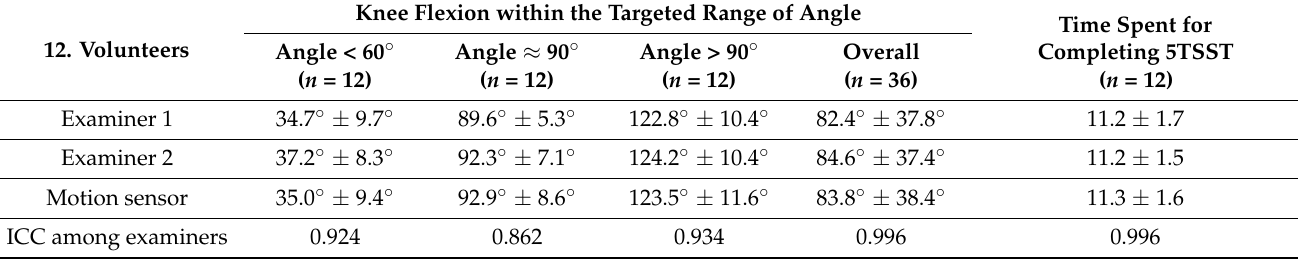
Table 1. Interobserver reliability between angle measurements and measurements of the time for performing 5-times sit-to-stand test obtained by different examiners.